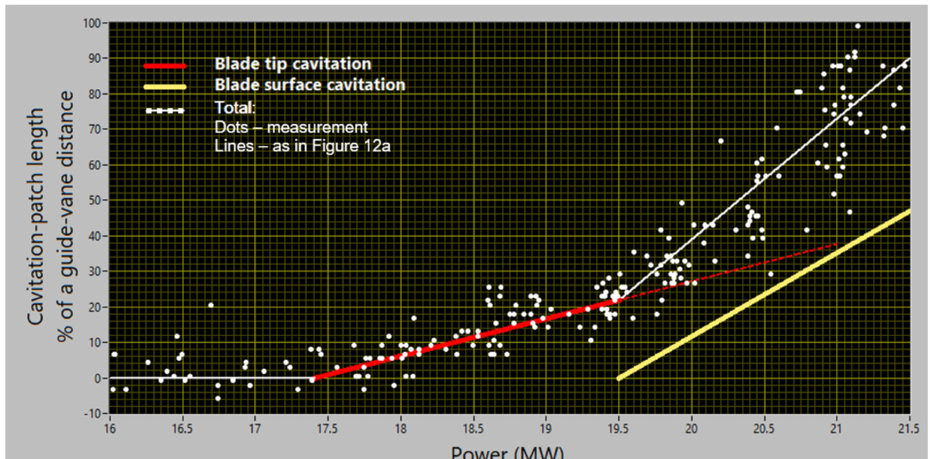
Figure A9. Origin of the lines in Figure 20. The straight-line model for the total cavitation follows the trends of the measured data for the shift of cavitation peaks with the increasing load; they were already noted in Figure 12a. The zero points of the red and yellow lines roughly coincide with the thresholds of the two cavitation mechanisms as in Figure 17; this is how they become attributed to the two mechanisms. While the solid red line here simply follows the dots, the yellow line is heuristically estimated by the difference between the total trend and the extrapolated trend of the low power, i.e., tip